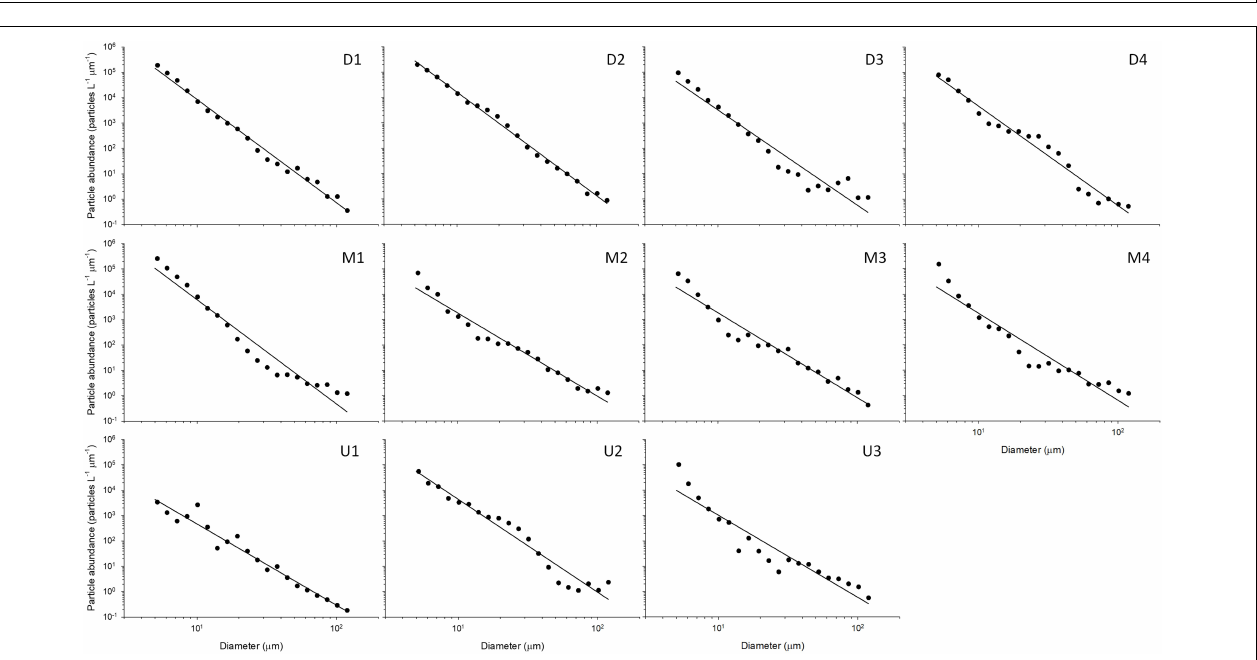
FIGURE 5 | Particle parameters in the Kuroshio region observed by Laser In-Situ Scattering and Transmissometry (LISST) during the KH-15-4 cruise. (A–C) Total particle volumes, abundance, and the slope of the particle size distribution slope ( ξ ) in the size range of 5.2–119 µ m, respectively. Data are shown as in Figure 2 and values are shown in Table 2